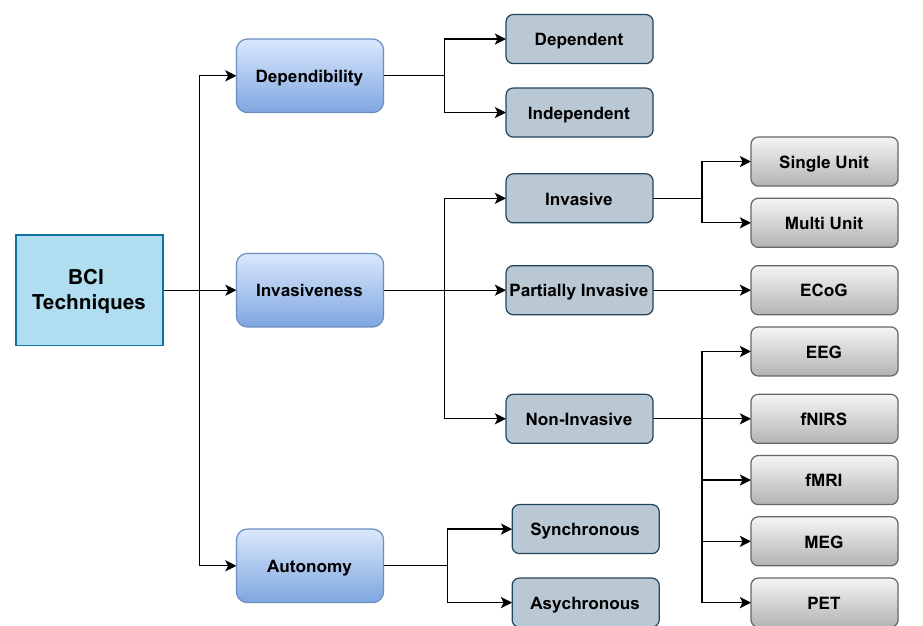
Figure 3. The classification/taxonomy of the BCI